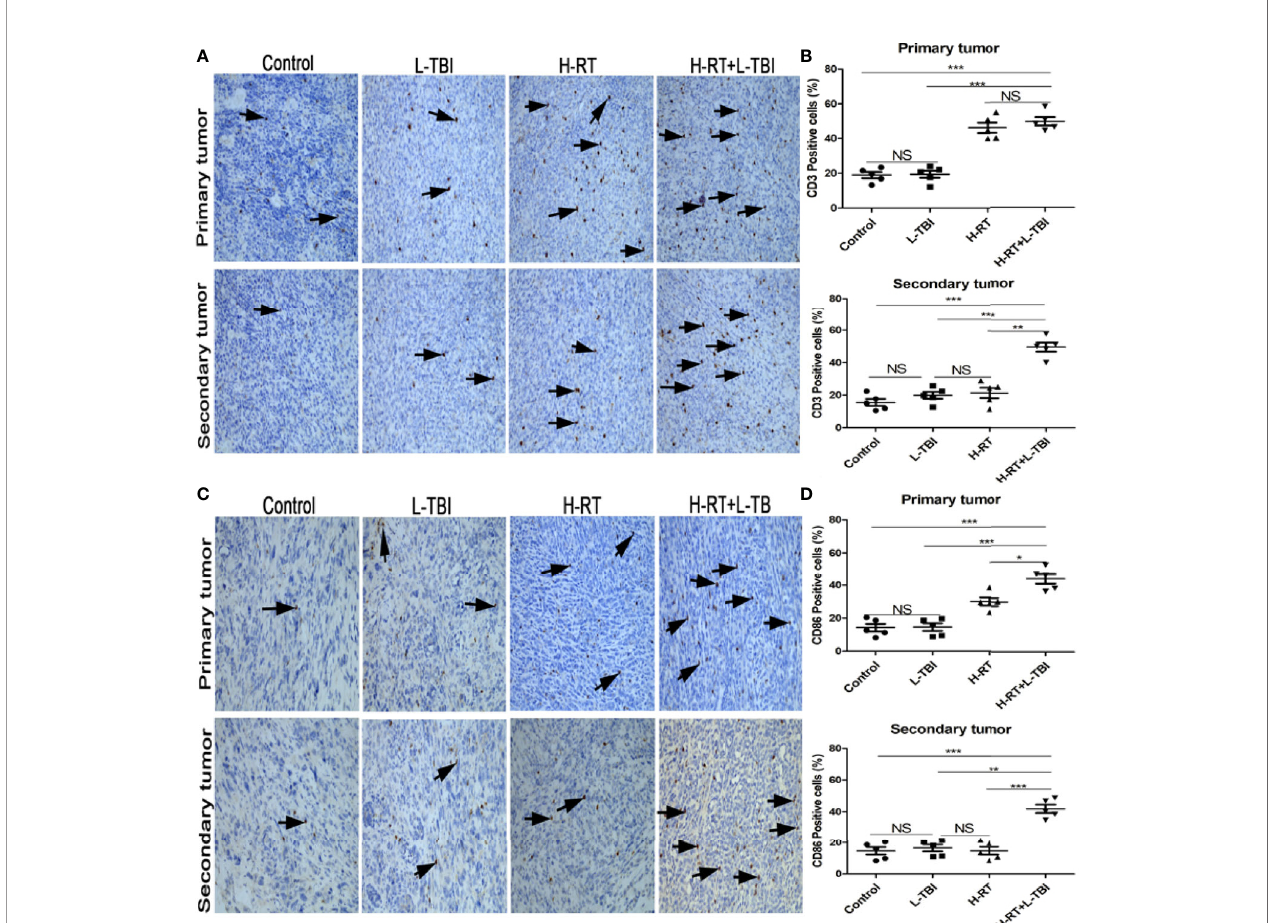
FIGURE 4 | Comparison of CD3+ and CD86+ lymphocytes in different treatment groups. (A) Representative images of CD3 IHC in tumor tissues of different treatment groups. (B) Percentage of CD3 positive cells in the primary and secondary tumor. (C) Representative IHC images of CD86 in fi ltration in the tumor tissue of different treatment groups. (D) Percentage of CD86 positive cells in the primary and secondary tumor. The arrows point the CD3 and Cd86 positive cells in tumor tissues from mice that received different treatments (original magni fi cation ×200). Data are expressed as mean ± SE of 5 mice/group. (*P < 0.05, **P < 0.01, ***P < 0.001, and NS, not signi fi